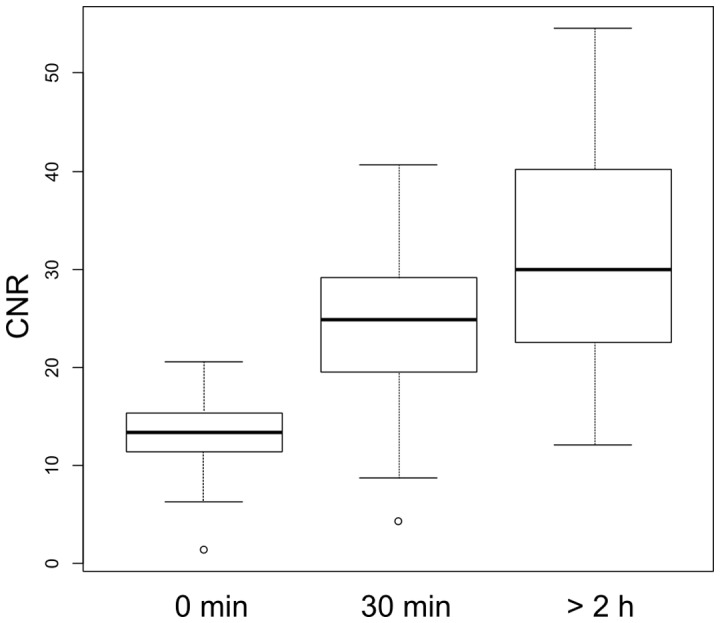
Boxplot of CNR values for pooled tumors at T  = 0 min (24 tumors in 7 animals), 30 min (29 tumors in 7 animals) and >2 h (31 tumors in 6 animals).P0–30 min <0.0001, P0 min–2 h <0.0001, P30 min–2 h  = 0.0074.